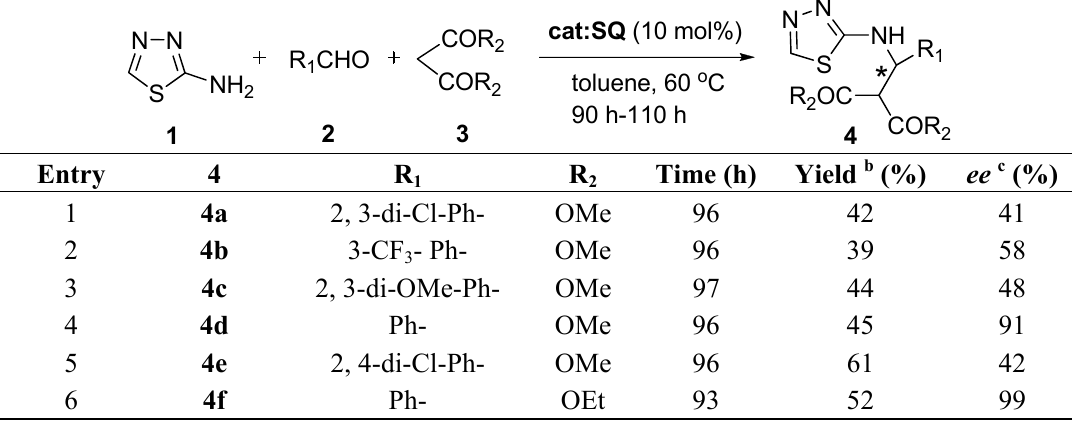
Table 3. Enantioselective Mannich reaction of 2-amino-1, 3, 4-thiadiazole, aldehyde, and malonate catalyzed by the SQ catalyst a .